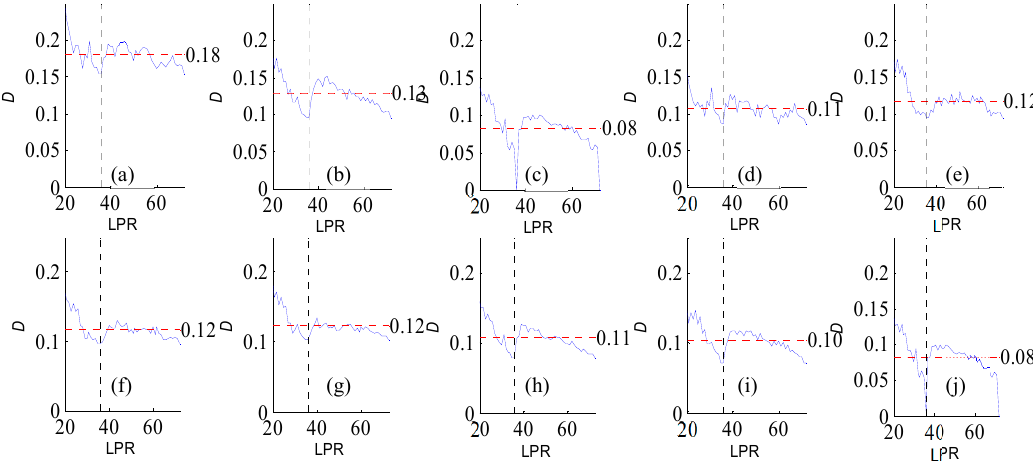
Figure A24. Variation of flow regime alteration degree (D) measured by the RVA with change in the length of post-impact flow time series (LPR) under a periodicity of 36 years. ( a – j ) correspond to pre-impact flow time series length = 26, 31, 36, 41, 46, 51, 57, 62, 67, and 72 years, respectively. The abscissa value for the vertical dotted line is 37. The ordinate value for the horizontal dotted line is the mean degree of flow regime alteration in each subfigure.